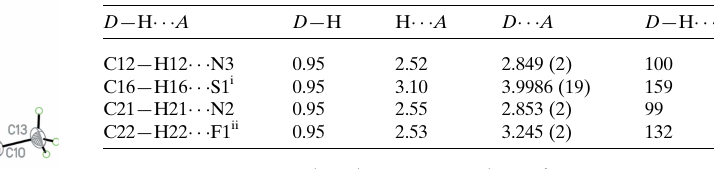
Table 1 Hydrogen-bond geometry (A˚ , (cid:3) ).